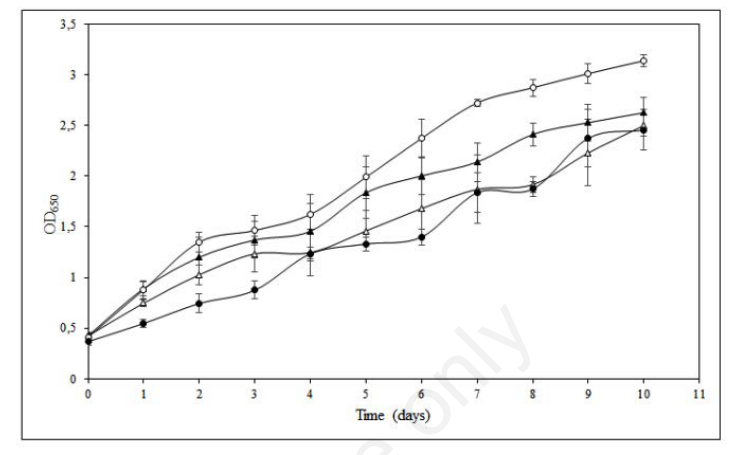
Figure 1. Growth curves for Botryococcus braunii batch cultures supplemented with NaHCO